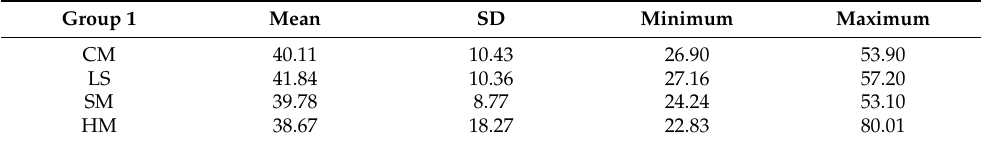
Table 2. Mean, standard deviation (SD), minimum and maximum ( µ m) marginal discrepancies values of in frameworks with intermediate pontic.